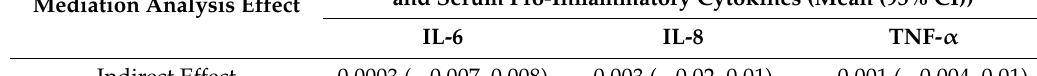
Table 3. Adjusted analyses for the NO 2 -cytokine relationship mediated by post-bronchodilator airflow obstruction 1,2